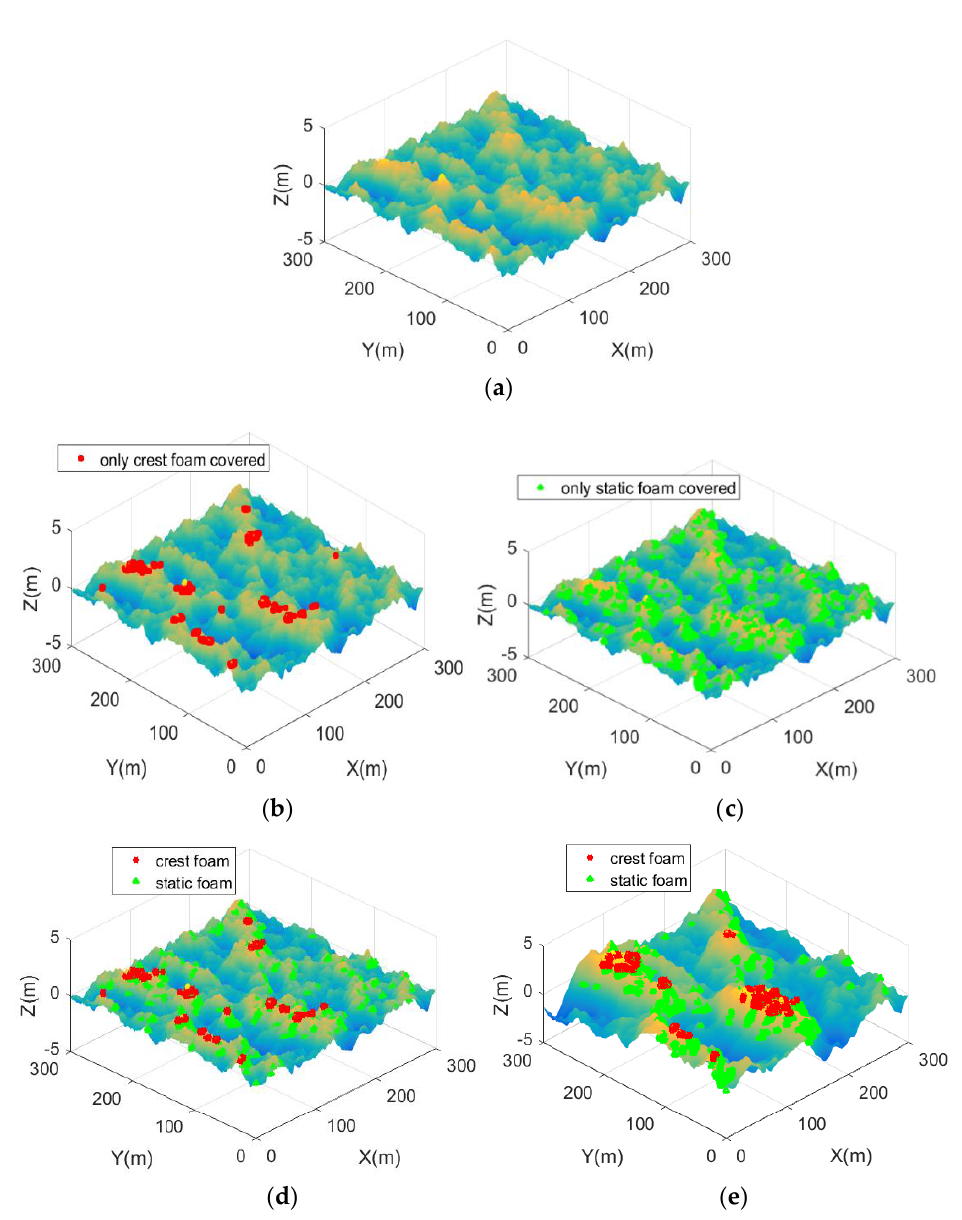
Figure 4. The whitecap coverage in the sea surface. ( a ) The sea surface without foam. ( b ) The sea surface covered with crest foam only. ( c ) The sea surface covered with static foam only. ( d ) The sea surface covered with the proposed distribution of crest foam and static foam for U 10 =10 m/s. ( e ) The sea surface covered with the proposed distribution of crest foam and static foam for U 10 =15 m/s.